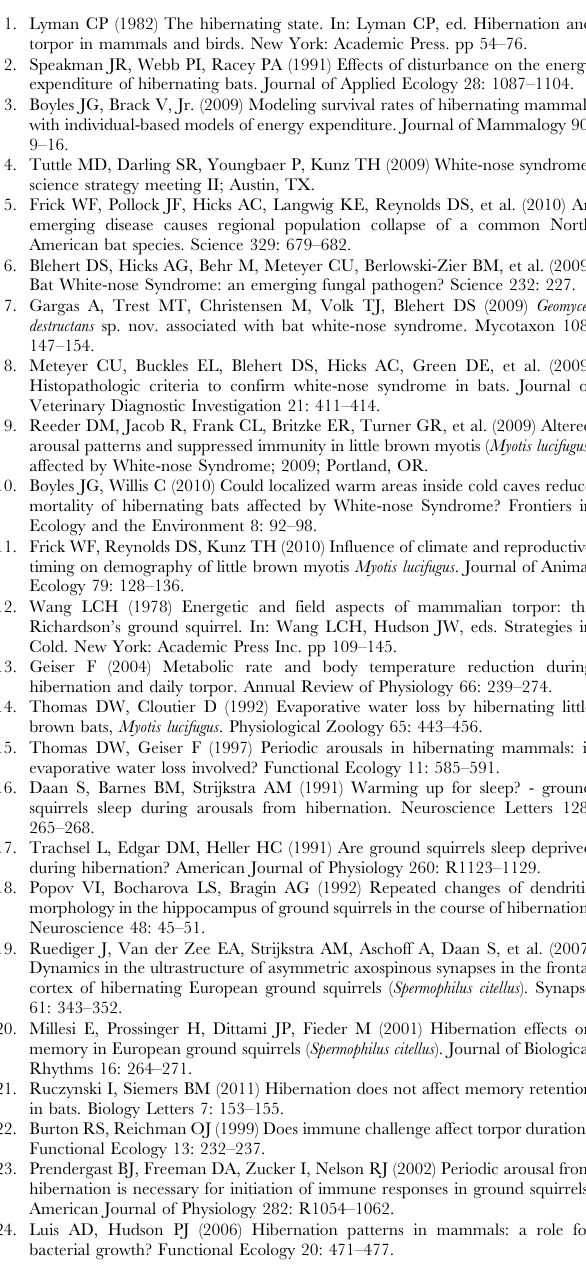
Figure S1 Monthly average ambient temperature